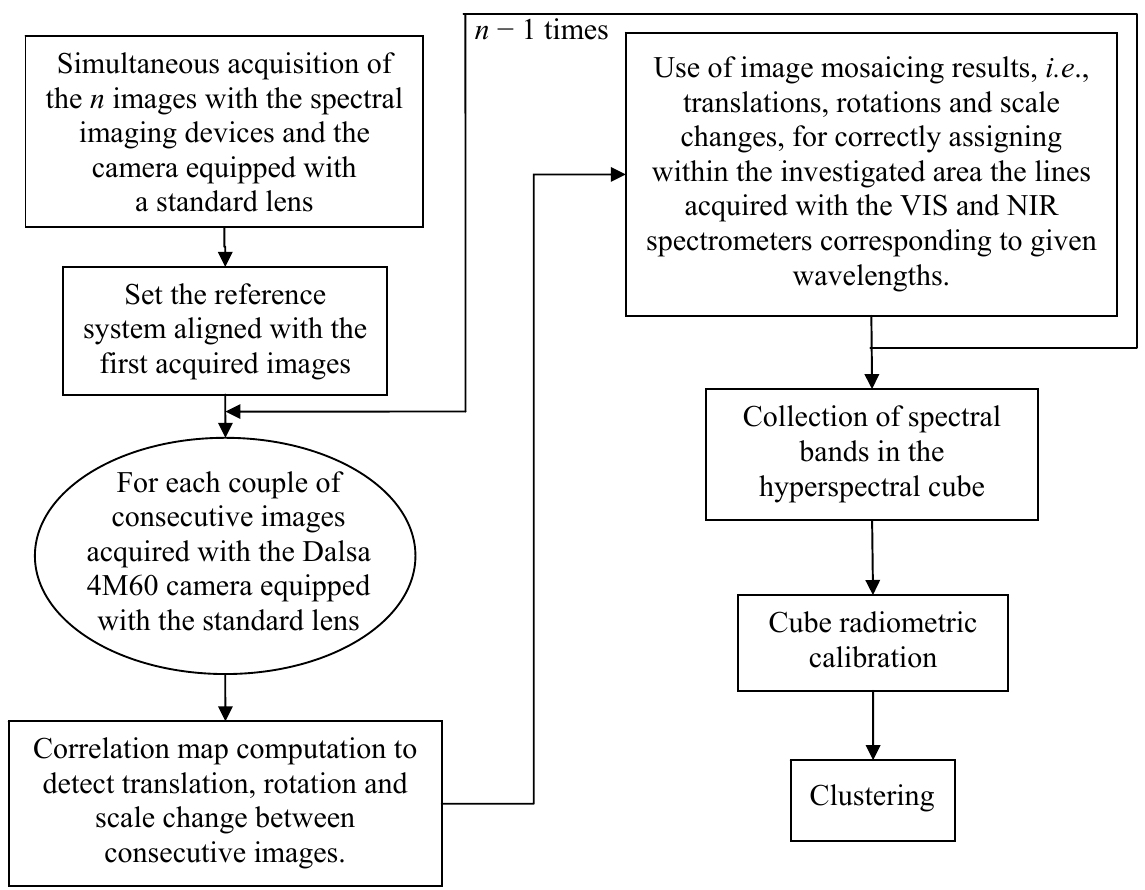
Figure 1. Schematic diagram explaining the main steps in the